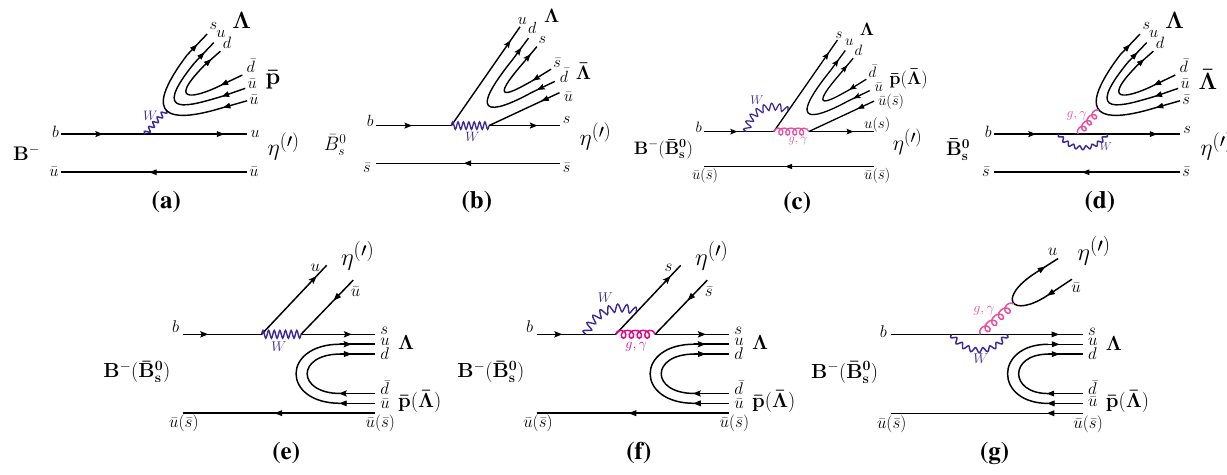
Fig. 2 Feynman diagrams for B − → (cid:3) ¯ p η ( (cid:3) ) and ¯ B 0 s → (cid:3) ¯ (cid:3)η ( (cid:3) ) decays through a – d B → η ( (cid:3) ) transitions with 0 → B ¯ B (cid:3) productions and e – g B → B ¯ B (cid:3) transitions with the recoiled η ( (cid:3)